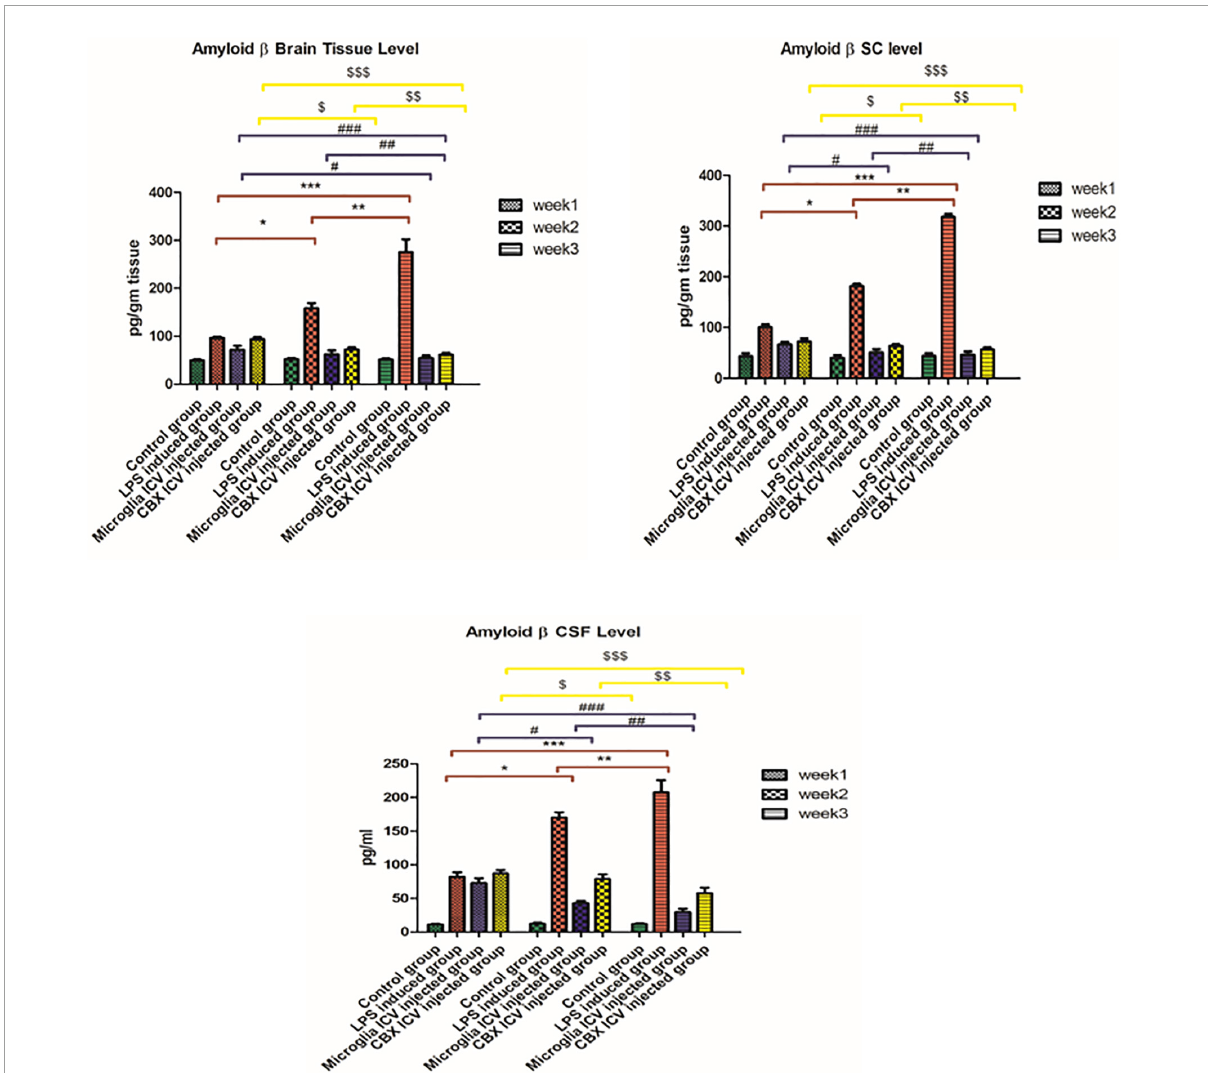
FIGURE4 Illustration of A β expression levels in brain tissue, spinal cord, and cerebrospinal fluid (CSF) in the lipopolysaccharide (LPS)-induced rats and following the single intracerebroventricular (ICV) administration of primary healthy microglia (PHM) and carbenoxolone (CBX) over the 3-week time interval. Represented data were expressed as mean ± SD ( n = 6 per group) (ANOVA, repeated measurement, Bonferroni post-hoc test, p < 0.05). The same asterisks represent an insignificant difference p > 0.05.